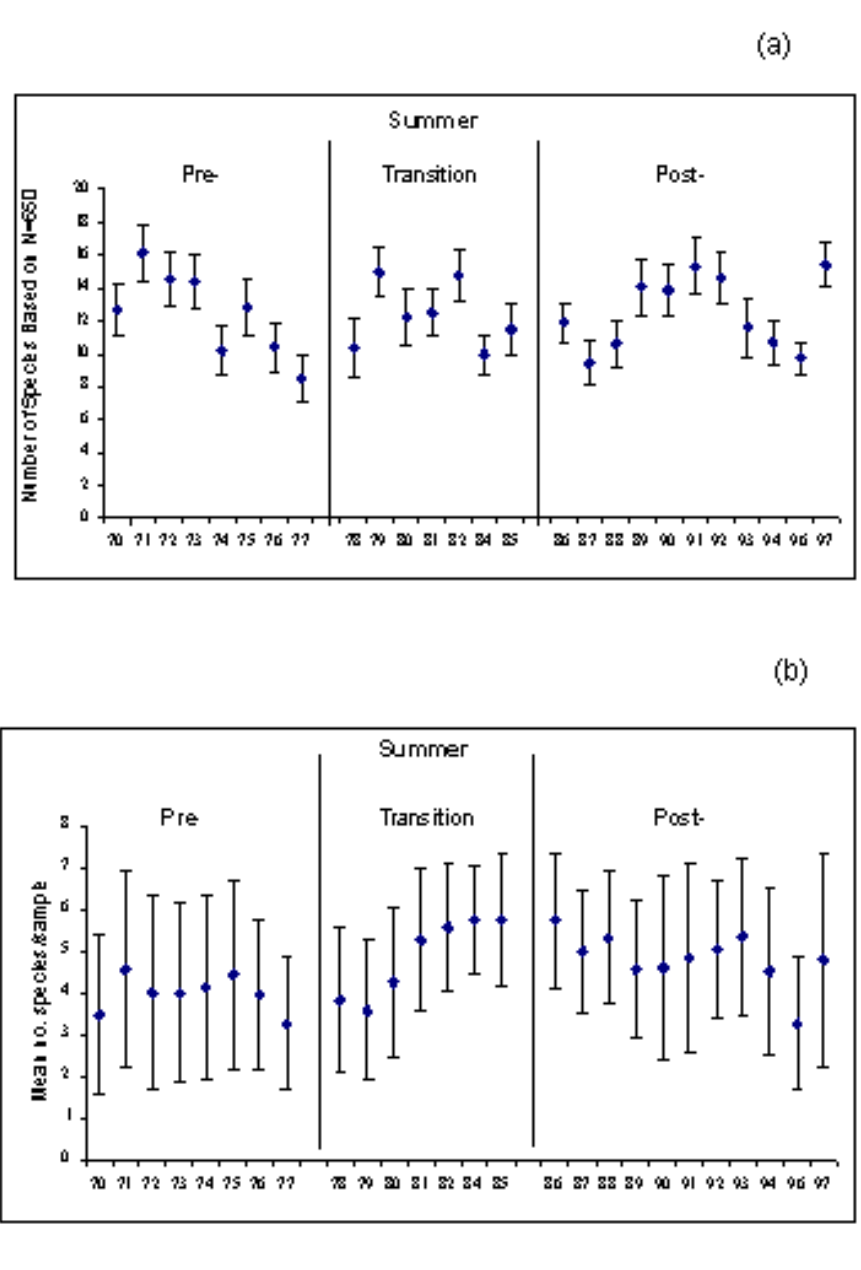
FIGURE 2. Species richness (a) and species density (b) in the vicinity of Salem during preoperational, transitional, and operational